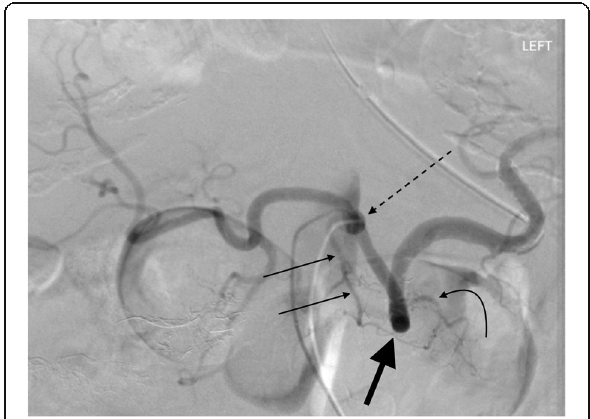
Fig. 2 65 year old female undergoing celiac angiogram for upper gastrointestinal bleed. Celiac DSA showing the dorsal pancreatic artery (thin arrows) arising directly from the celiac trunk (dotted black arrow), which occurs in ~ 15% of cases. The great pancreatic artery (curved black arrow) arises from the mid portion of the splenic artery. Ideal placement of coils/plugs in proximal splenic artery embolization is between these two vessels. Transverse pancreatic artery (thick black arrow)